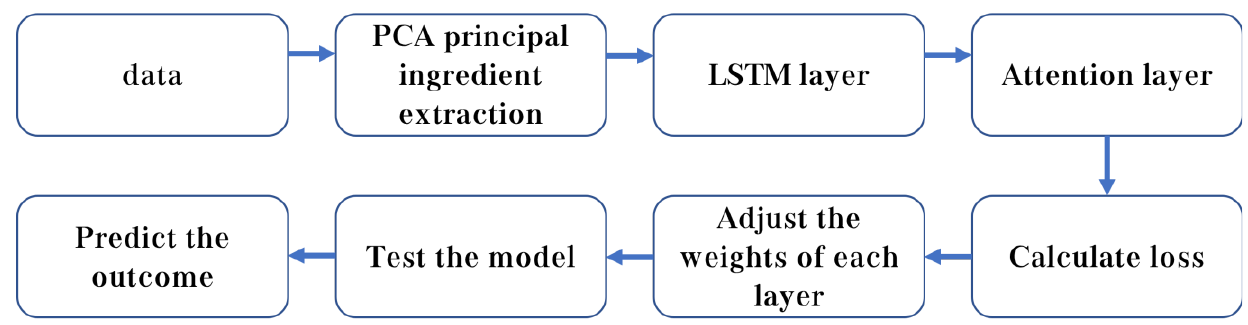
Figure 7. PCA-attention-LSTM model technical roadmap.